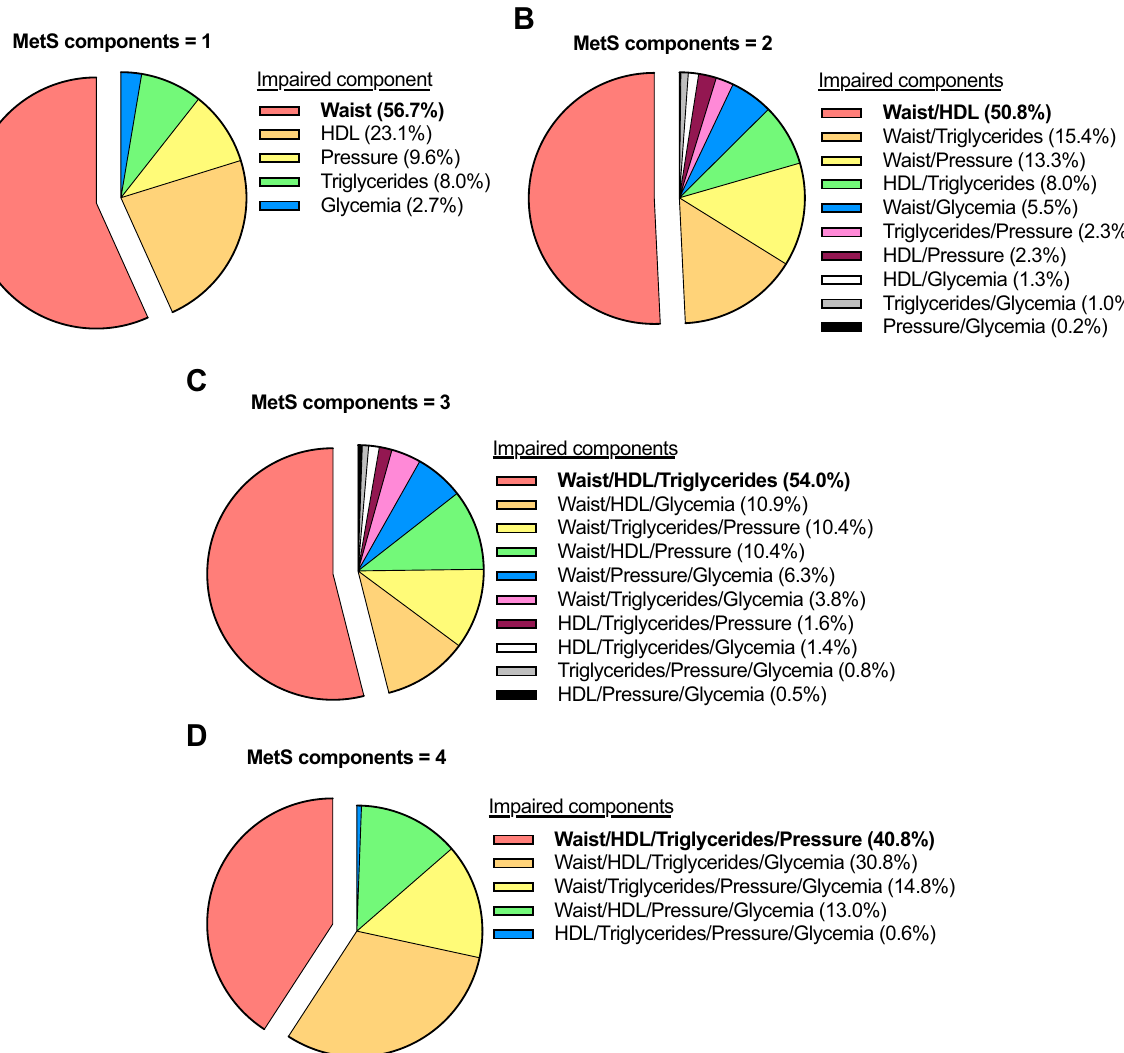
Figure 2. Prevalence of combinations of metabolic syndrome (MetS) components in subjects with ( A ) one, ( B ) two, ( C ) three, or ( D ) four impaired components. Waist, waist circumference; HDL, high-density lipoprotein cholesterol; Pressure, blood pressure.